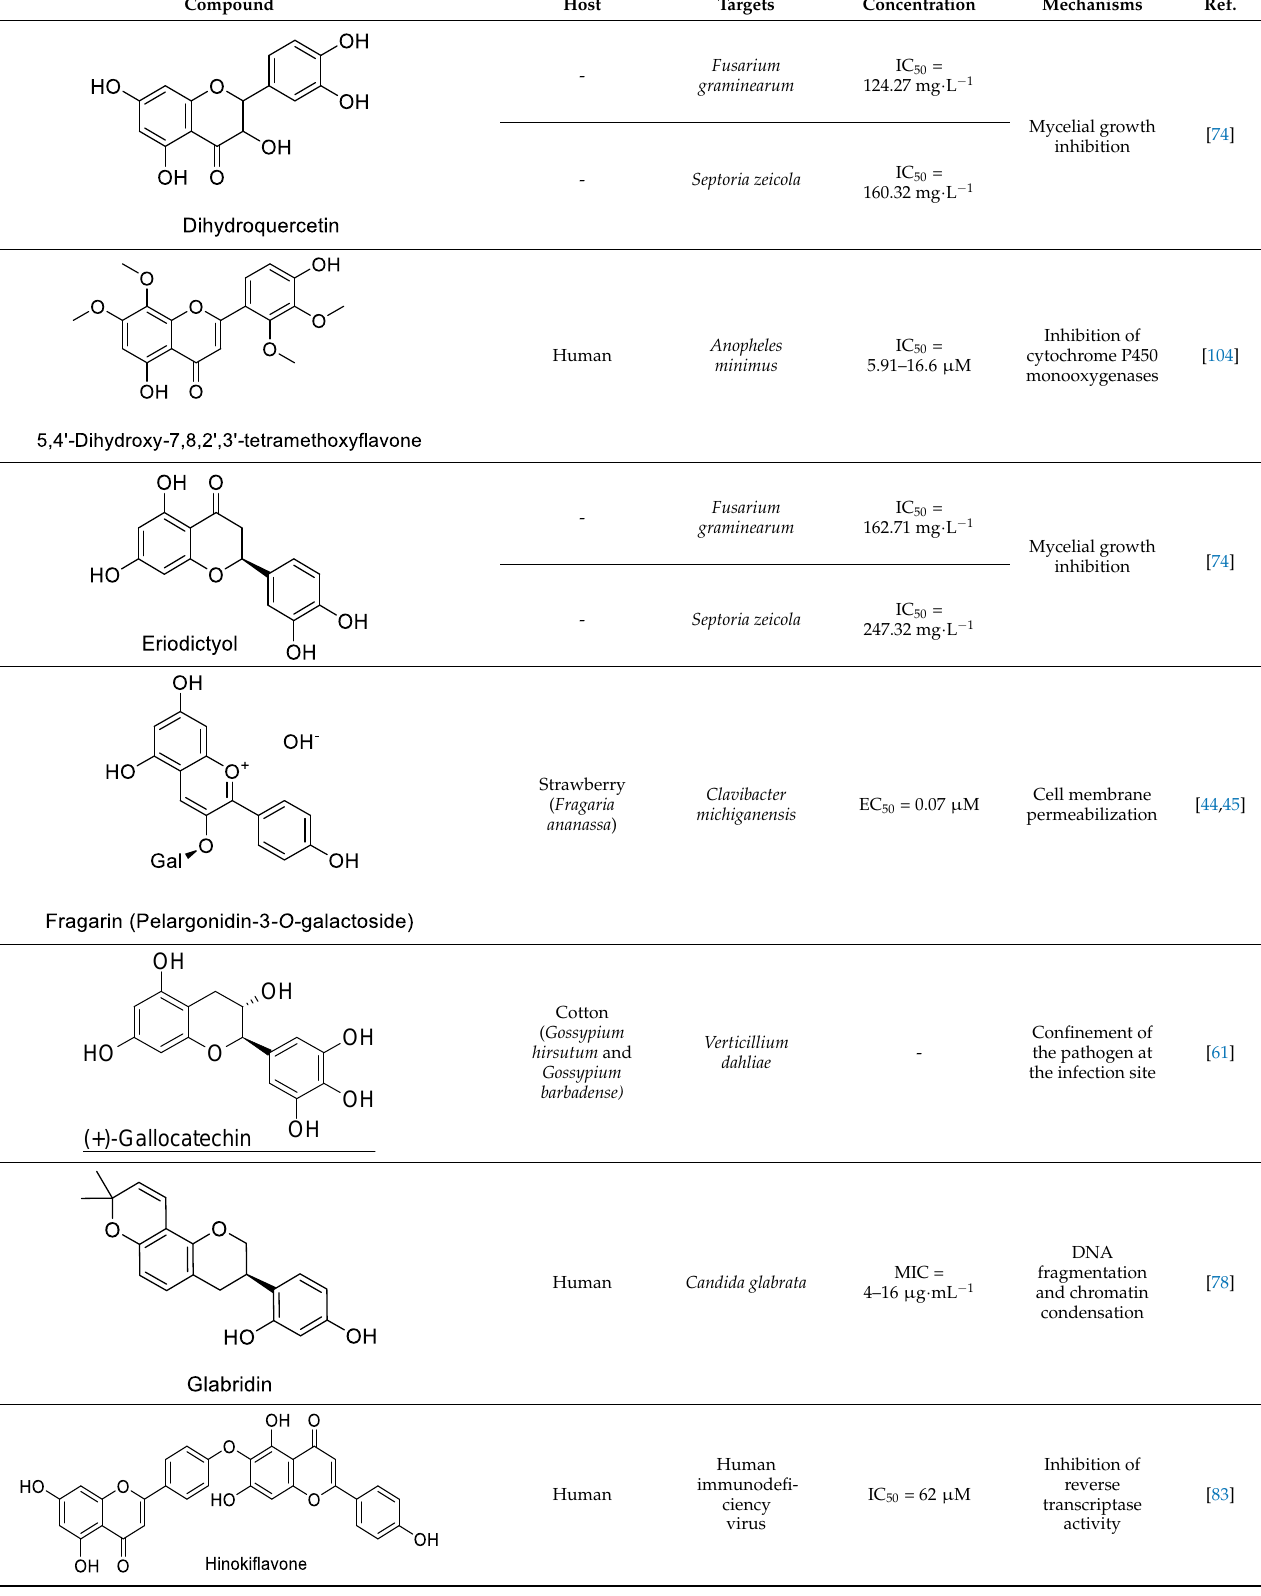
Table 1. Cont. Compound Concentration